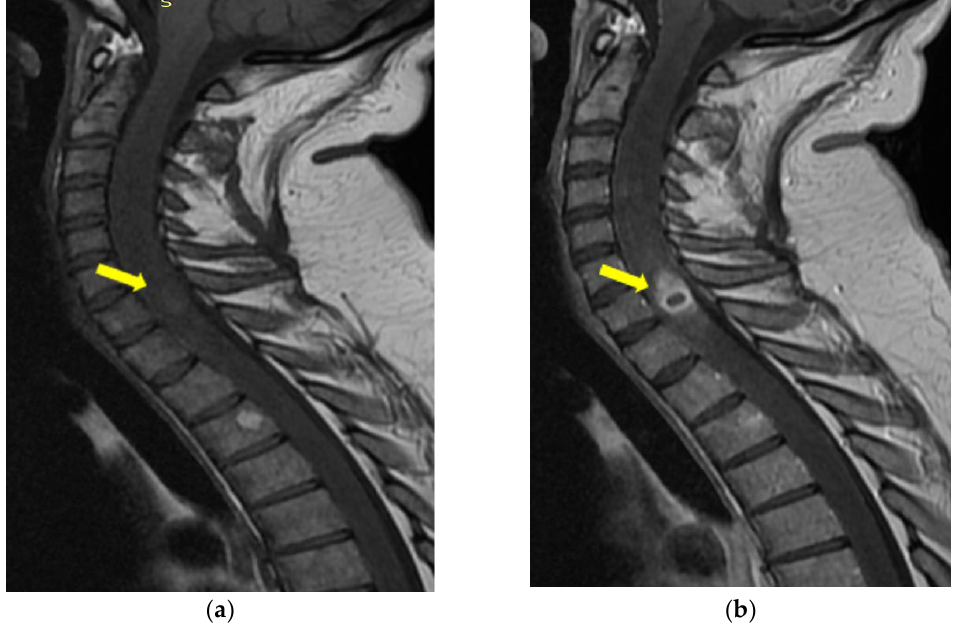
Figure 6. MRI of the cervical sagittal spine T1-weighted image ( a ) and after intravenous Gd-chelates ( b ): ring-enhancing mass within cord. The yellow arrow indicates the expansive cystic intramedullary process.